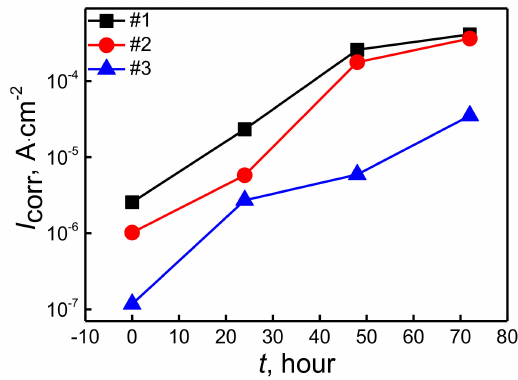
Figure 4. Corrosion current density of electrodes at different corrosion